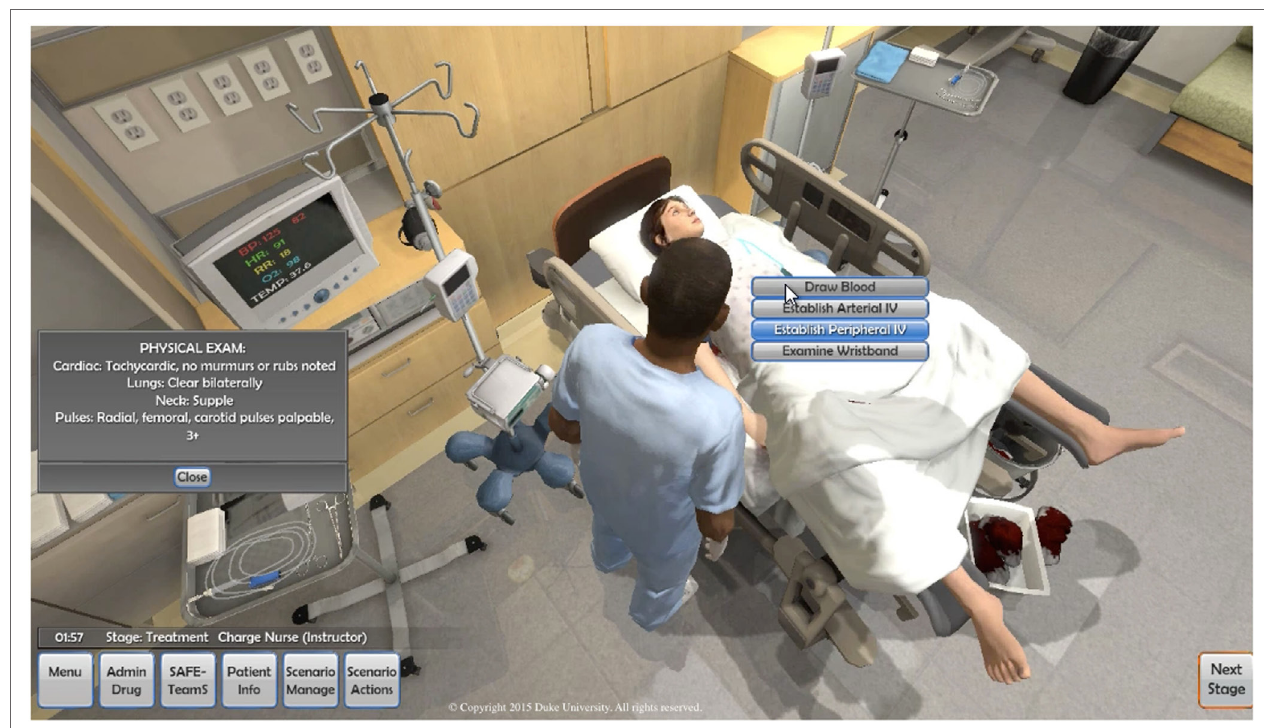
FigUre 1 | Screen-shot of 3DiTeams—postpartum hemorrhage—multiplayer screen-based simulation. Each character is controlled by a unique individual using a computer, mouse, and voice-over-IP